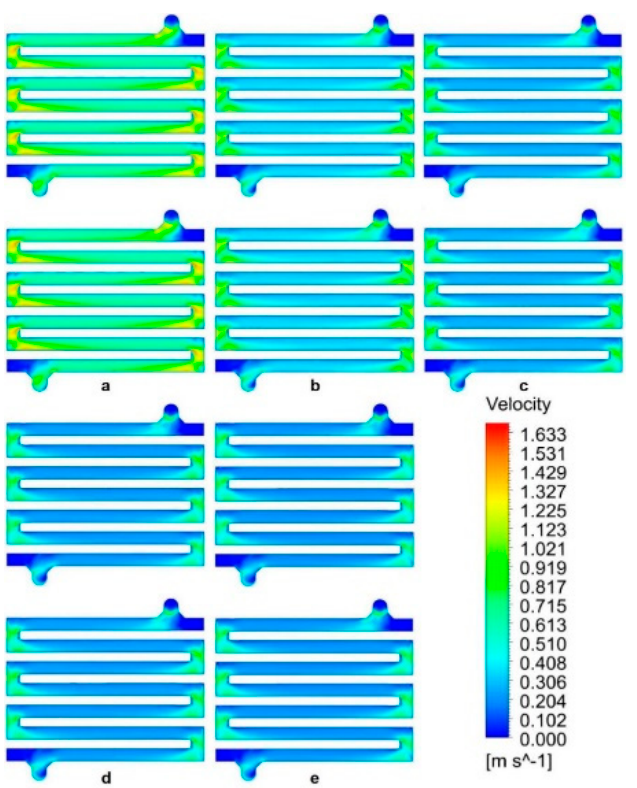
Figure 8. Velocity contour plots for the inflow path through the spacer next to the membrane, for cases with an outflow zone (upper figures) and without an outflow zone (lower figures) grids; ( a ) 250,000 cells, ( b ) 500,000 cells, ( c ) 1,000,000 cells, ( d ) 1,500,000 cells and ( e ) 2,000,000 cells.